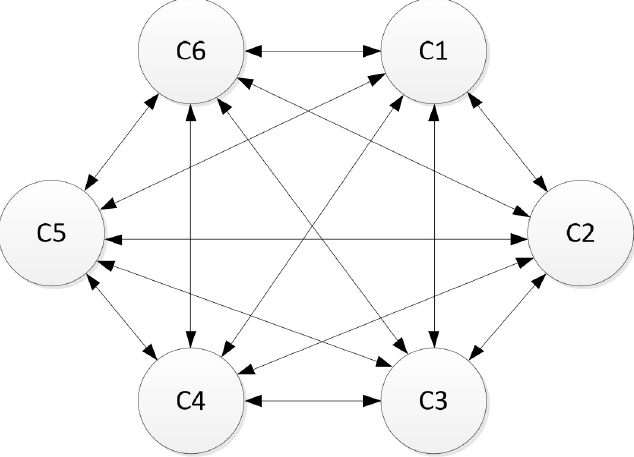
Figure 4. The inter relationships between the